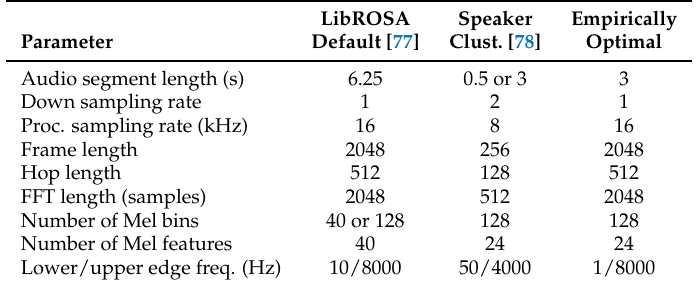
Table 6. Audio: List of parameters used to compute Mel-spectrograms and MFCCs.